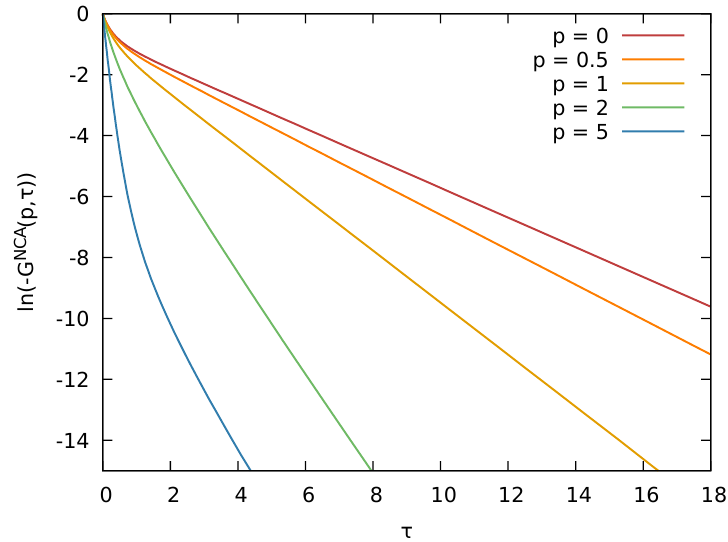
Figure 19: (Green’s functions in the NCA approximation for different momenta. Same param- eters as in Fig.